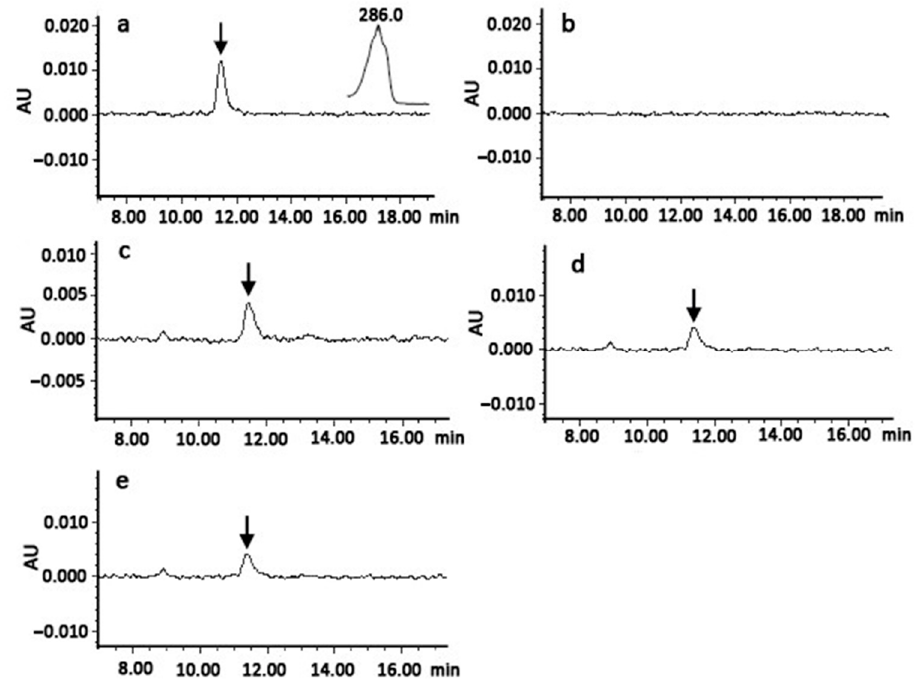
Figure 4. Functional complementation of watermelon ClPSY proteins. ( a ) E. coli cells harboring EB were used as a positive control. The peak represents phytoene (indicated by an arrow); ( b ) E+pET (empty vector) was used as a negative control; ( c ) E+ pET- ClPSY1 ; ( d ) E+ pET- ClPSY2 ; ( e ) E+ pET- ClPSY3 . The peak representing phytoene (indicated by an arrow) was observed in cells expressing ClPSY1 , ClPSY2 and ClPSY3 .